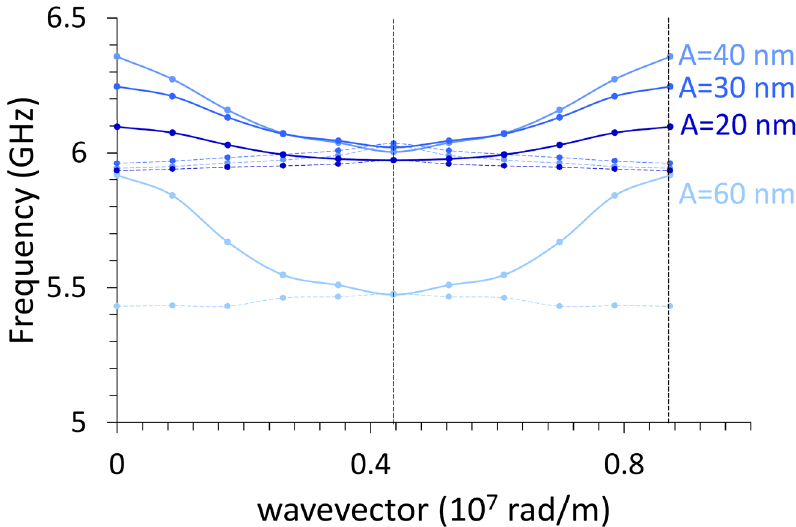
Figure 12. Dispersion relations of the edge mode with k (cid:31) M up to the second zone boundary, in a film with progressive undulation amplitude A, from 20 nm (4-stripe system, the darkest blue line) to 60 nm (12-stripe system, the lightest blue line), indicated by the blue shades from darker to lighter. Continuous lines refer to the first Brillouin zone, dashed lines to the (mirrored) second zone. The first three systems show a progressive frequency increase, while the 12-stripe edge dispersion (A = 60 nm) is at a very lowest frequency. The frequency band corresponding to the first zone is progressively increasing with the undulation